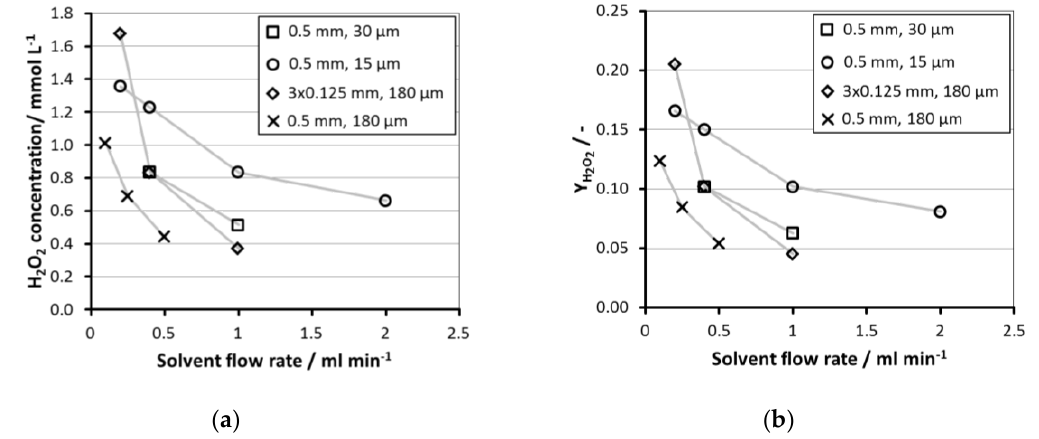
Figure 5. ( a ) Hydrogen peroxide concentration and ( b ) yield over solvent flow rate using 100 mg Pd/TiO 2 in a fixed bed in a PVC-tube at 10 bars system pressure with water with additives as solvent: squares: 0.5 mm deep microchannel, 30 μm Nafion ® membrane (Table 1 Exp.-Nr.: 63–64), circles: 0.5 mm deep microchannel, 15 μm Nafion ® membrane (Table 1 Exp.-Nr.: 54–57), diamonds: 3 × 0.125 mm deep microchannel, 180 μm Nafion ® membrane (Table 1 Exp.-Nr.: 46–48), crosses: 0.5 mm deep microchannel, 180 μm Nafion ® membrane (Table 1 Exp.-Nr.: 38–40).